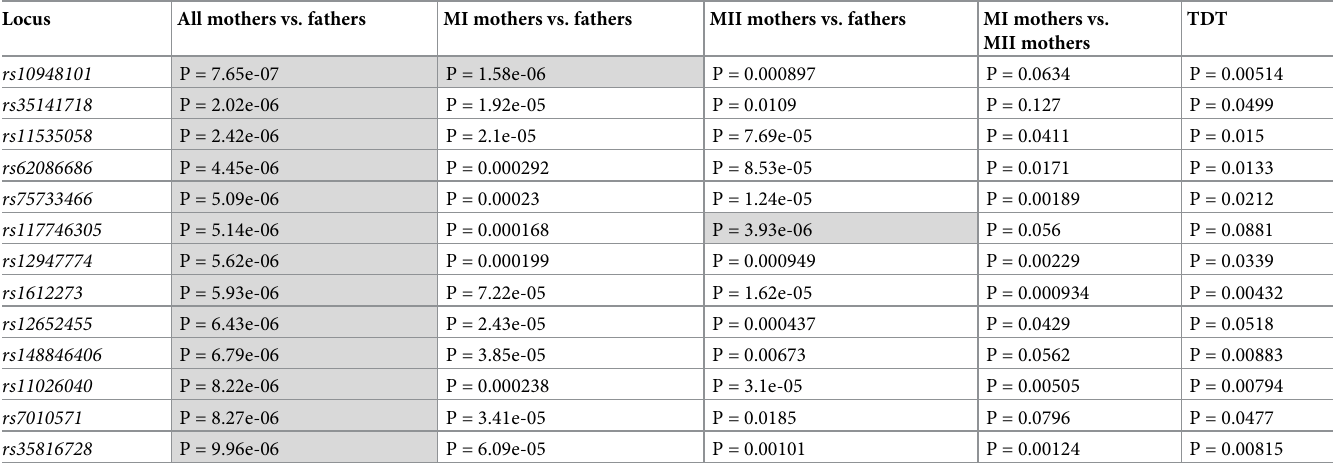
Table 3. Top hits from the all mothers vs. fathers genome-wide association study. Locus All mothers vs. fathers MI mothers vs. fathers